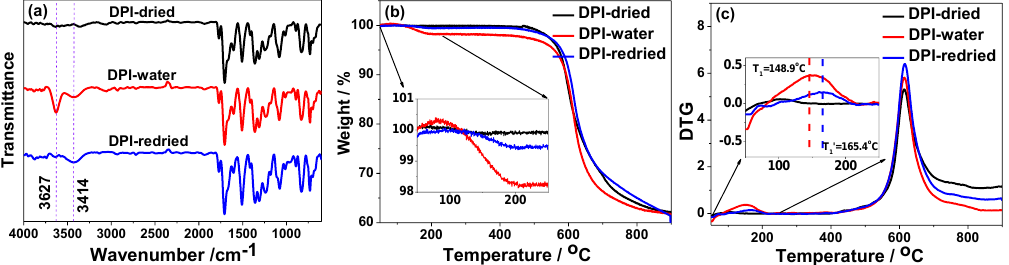
Figure 6. FT-IR spectra and thermogravimetric analysis (TGA) curves of the DPI films under different conditions. ( a ) FT-IR spectra; ( b ) TGA curves; ( c ) Derivative thermogravimetric analysis (DTG) curves.